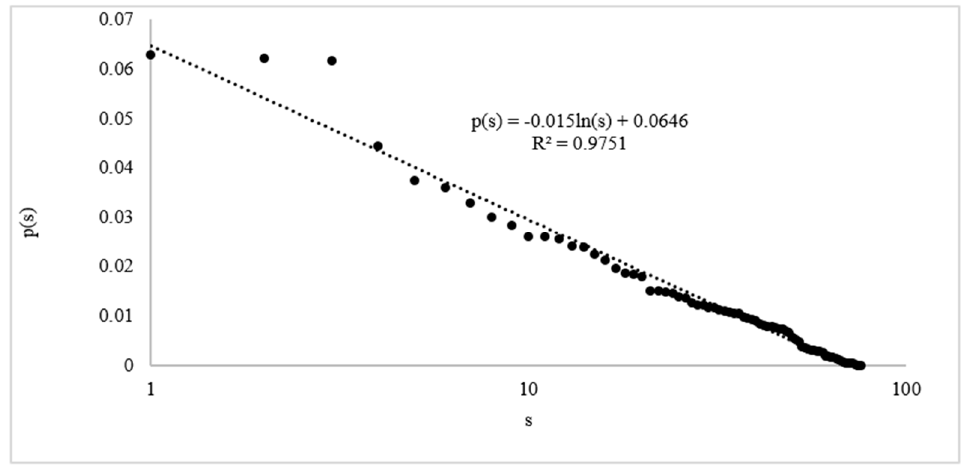
Figure 5. Intensity distribution of learning interest similarity network nodes among majors.